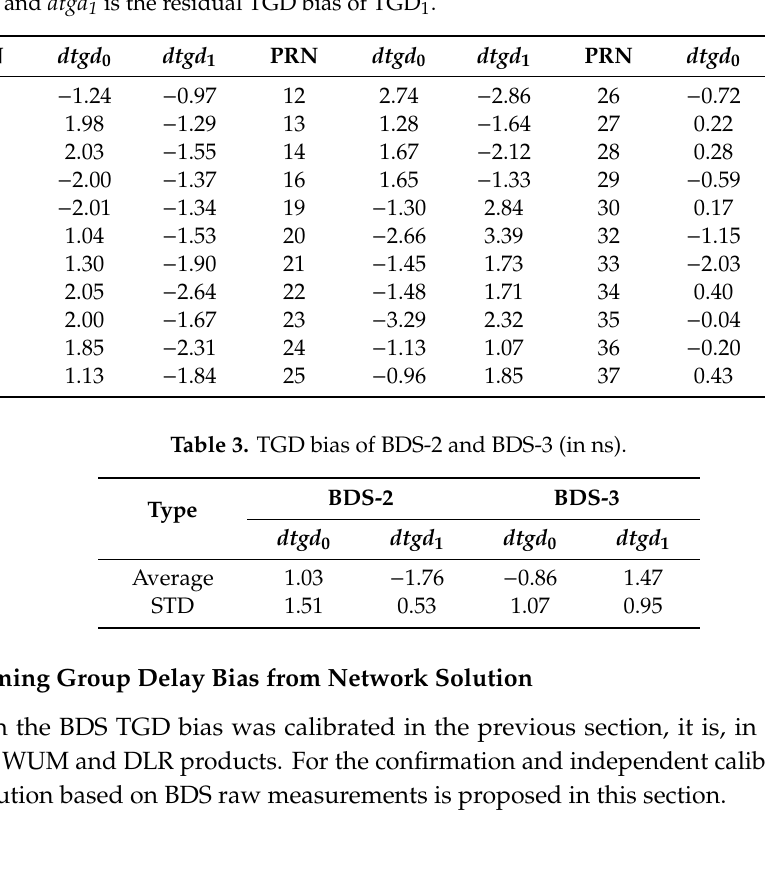
Table 2. Calibrated BDS TGD bias from precise products (in ns). dtgd 0 means the TGD bias at B3I frequency and dtgd 1 is the residual TGD bias of TGD 1 .